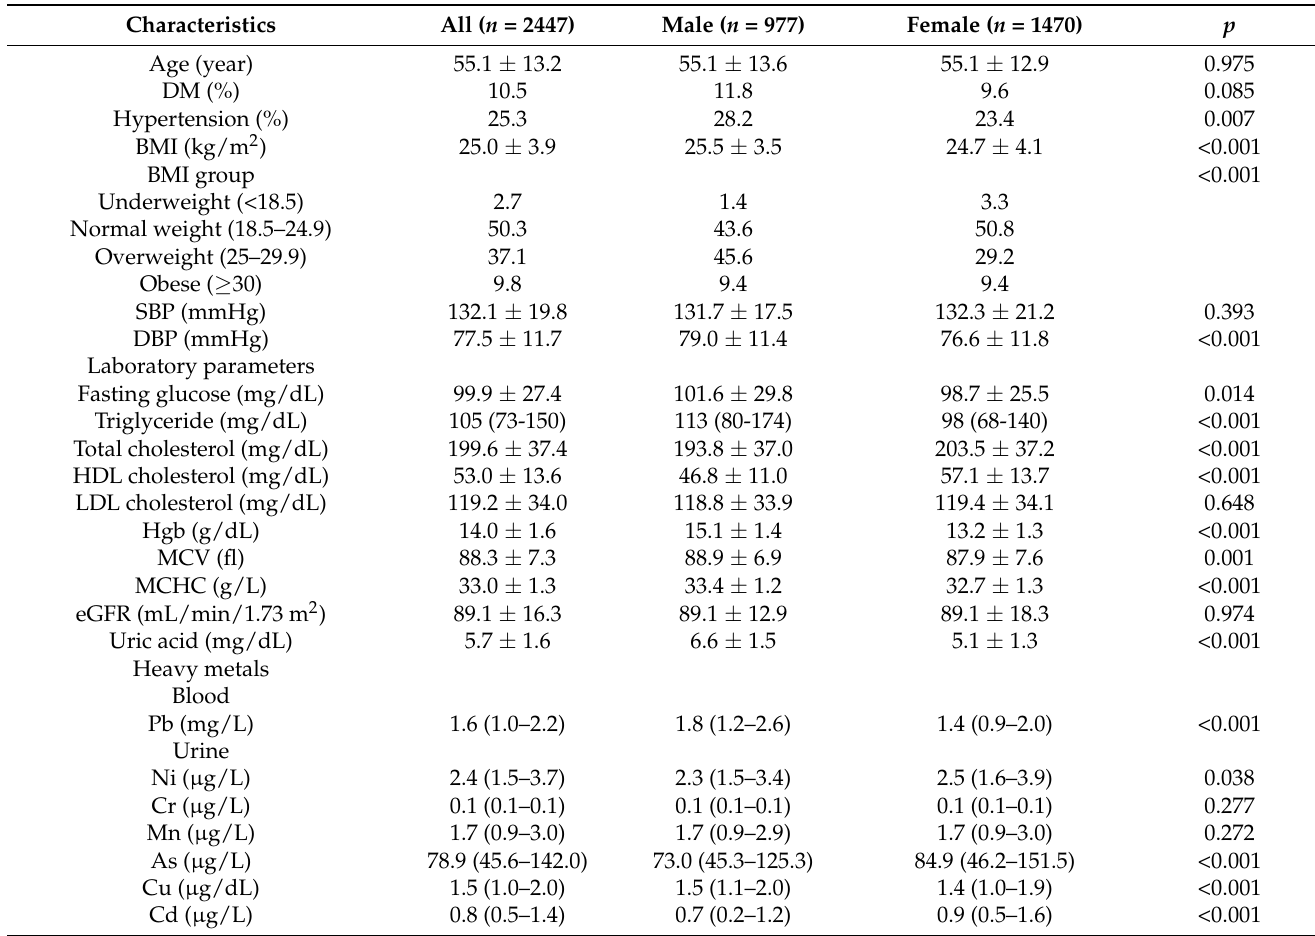
Table 1. Comparison of clinical characteristics among male and female